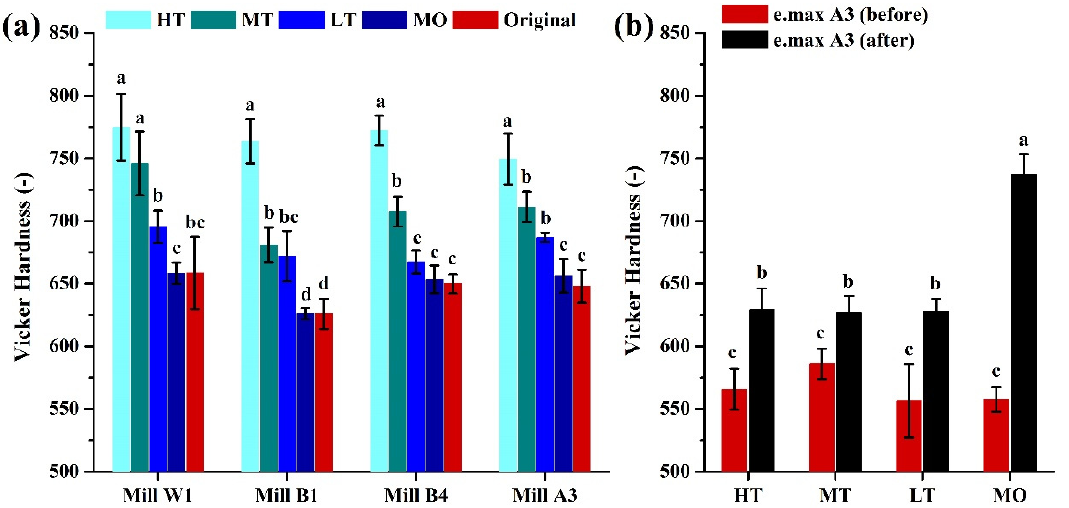
Figure 10. Surface microhardness of ceramic samples of different translucency extents and colors. ( a ) Amber Mill and ( b ) IPS e.max CAD. Means with different letters differ significantly ( p < 0.05, mean ± SD, n = 10).